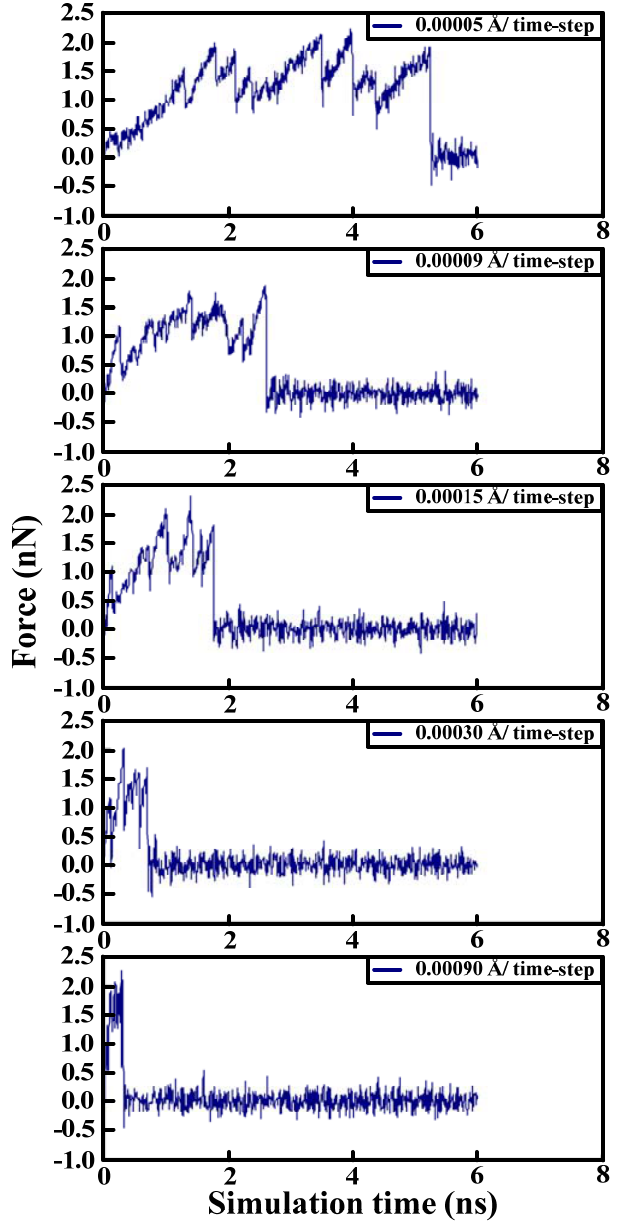
Figure 3. Corresponding force curves of pulling rates: 0.00005, 0.00009, 0.00015, 0.00030, 0.00090